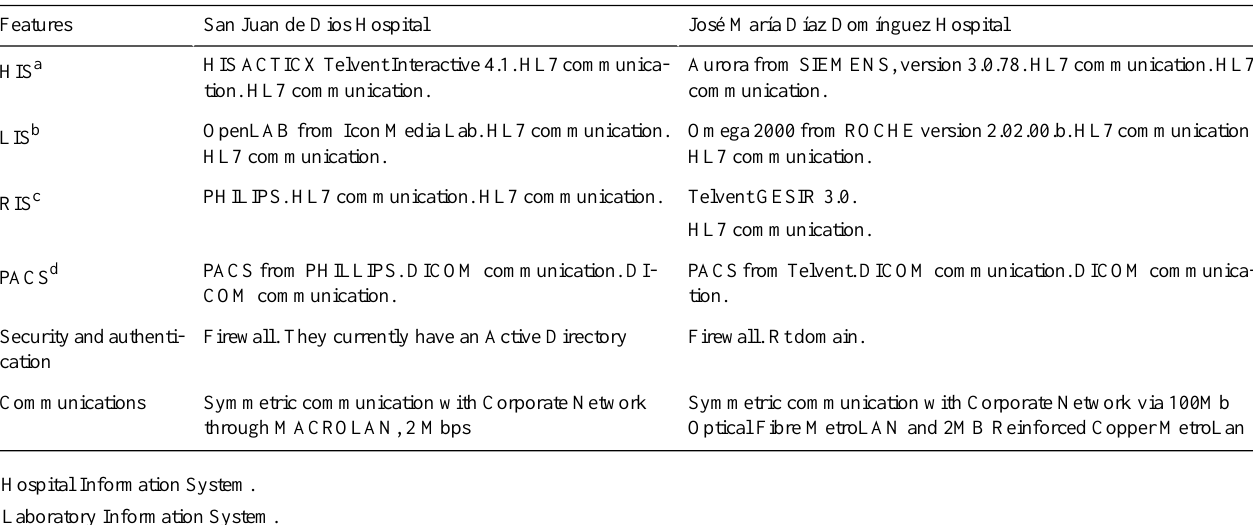
Table 1. Information systems at the two requesting